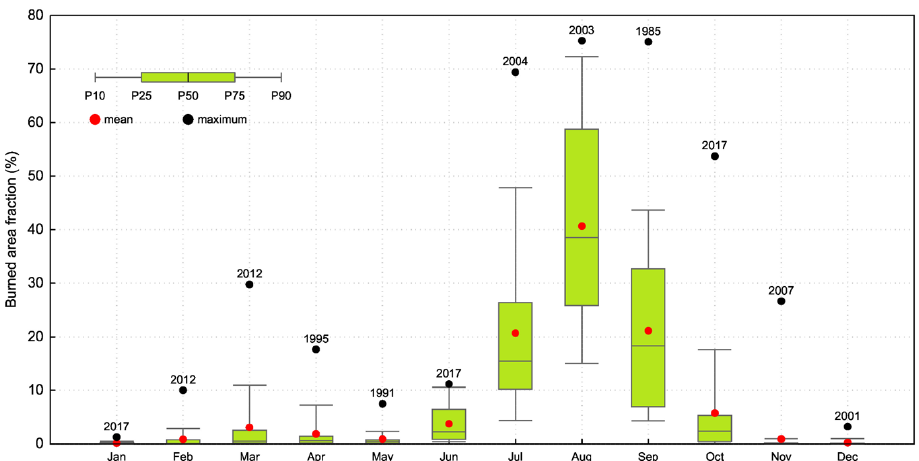
Figure 3. Distribution of the monthly fraction of annual burned area in the period of 1980 to 2018, indicating the 10th, 25th, 50th, 75th and 90th percentiles (box and whisker plot), the mean (red dots) and the maximum monthly values (black dots labeled with the year of occurrence).